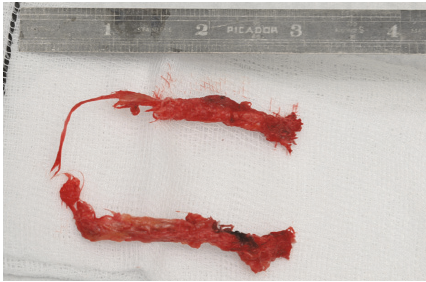
Figure 3: Intraoperative photograph demonstrating substantial fraying to LARS four months after insertion.